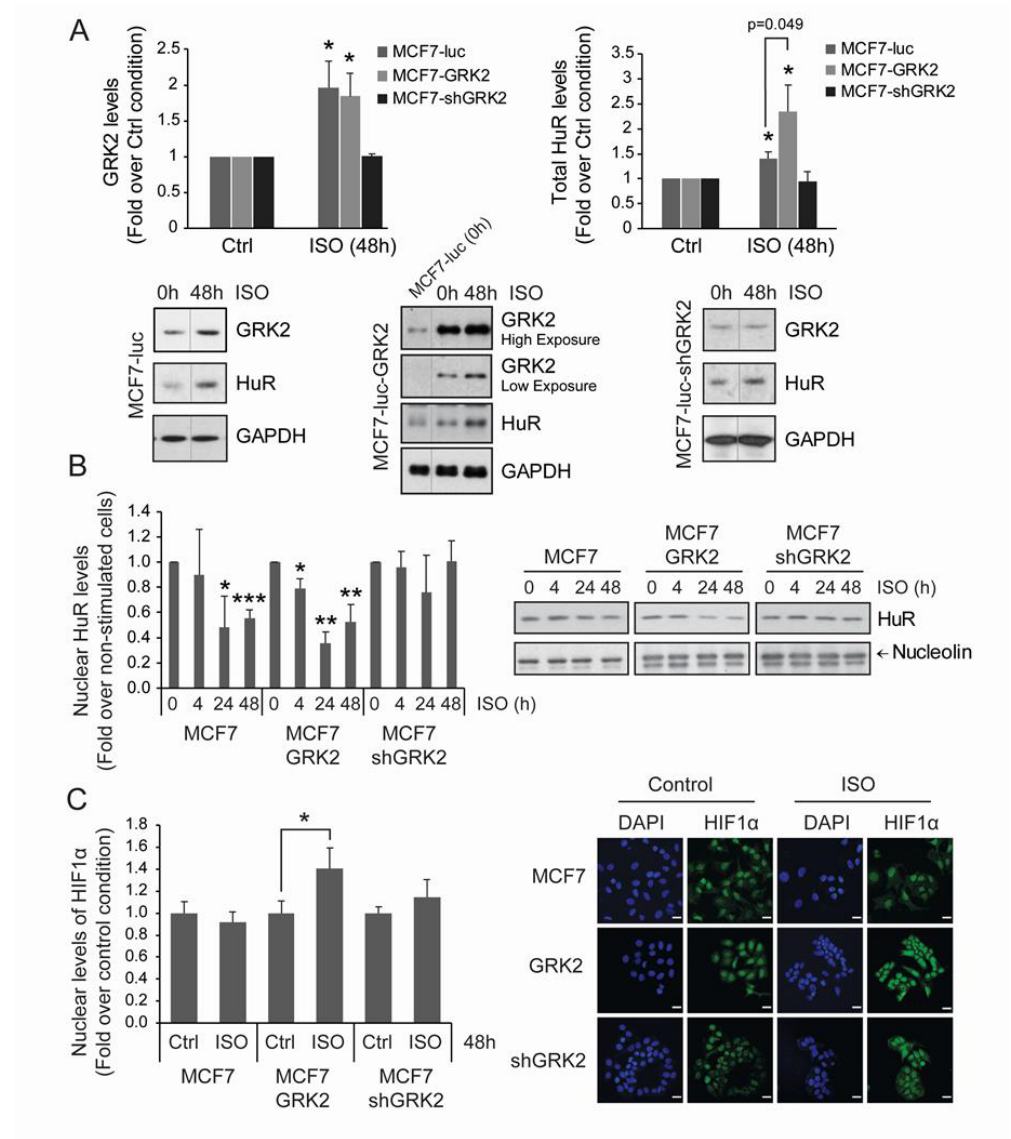
Figure 6. Chronic adrenergic stress leads to HIF1α accumulation through GRK2 and HuR upregulation in luminal breast cancer cells. Adrenergic signaling facilitates nuclear export of HuR in a GRK2-dependent manner. MCF7-luc (control MCF7 cells) and cells stably expressing GRK2-wt or shGRK2 were treated with 50 μM isoproterenol for the indicated times to induce adrenergic stress. Total GRK2 and HuR levels ( A ) and nuclear HuR levels ( B ) were analyzed by immunoblot with the indicated loading controls. ( C ) HIF1-α and DAPI nuclear marker levels were analyzed by immunofluorescence. Representative images are shown (scale bar, 25 μm). All values are mean ± SEM from three independent experiments. * p < 0.05, ** p < 0.01, *** p < 0.001 (Student’s t -test). Detailed information about the Western blot can be found in Figure S8.